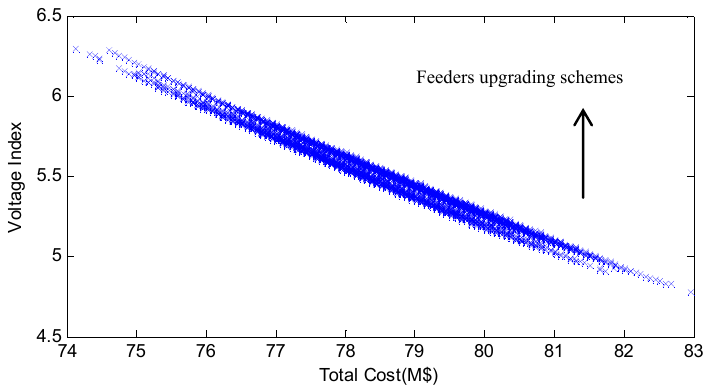
Figure 10. Costs, voltage index projection graph.